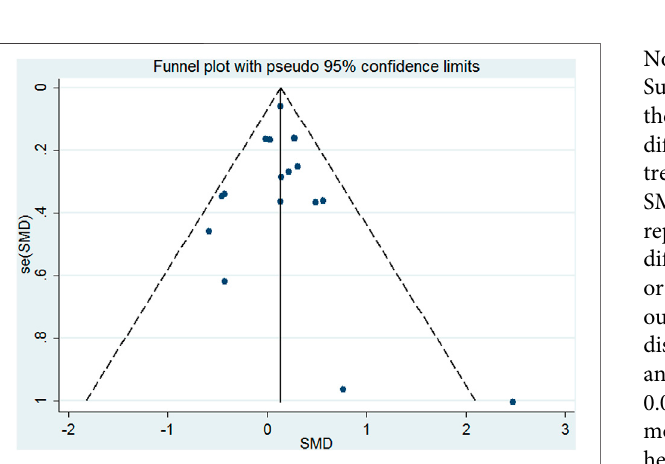
Frontiers in Pharmacology |